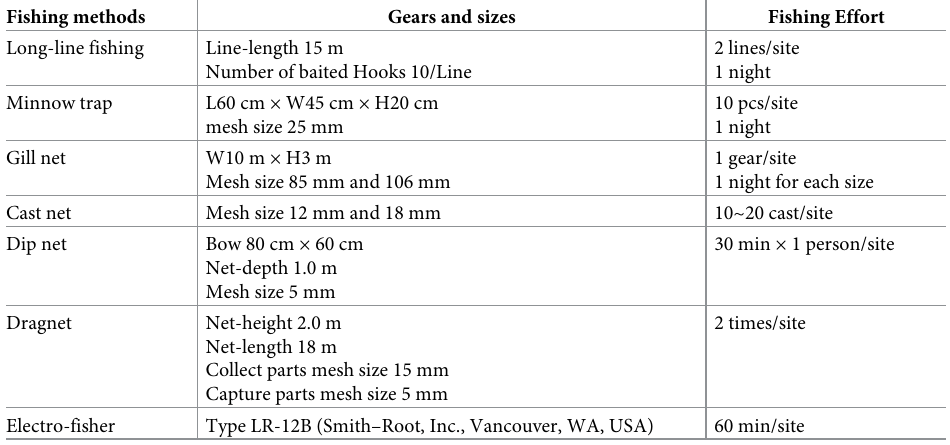
Table 1. Capture methods employed in this study, including the fishing equipment size and effort. Fishing